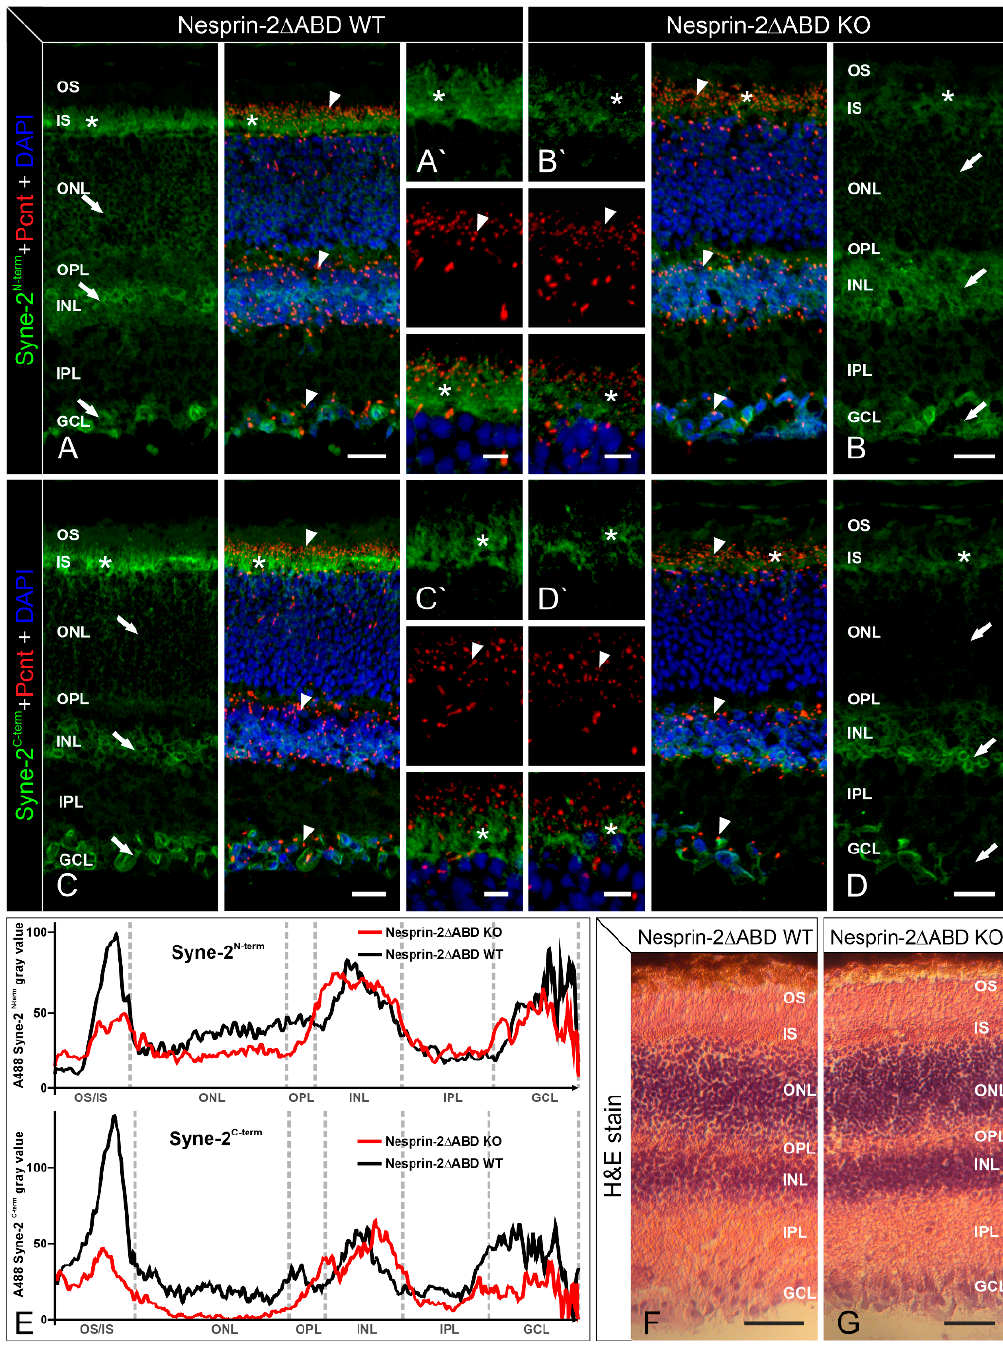
Figure 1. Light microscopic and immunofluorescence analysis of Pcnt and Syne-2 in retinae of Nesprin-2 ∆ ABD mouse strain. Images of vertical sections through adult (age 2–4 month) Nesprin-2 ∆ ABD mouse retinae, stained with antibodies against Syne-2N-term (K56-386, green, A, B) or Syne-2C-term (F-11, green, C, D), Pcnt (MmPeriC1, red), and DAPI (blue). ( A , C ) In Nesprin-2 ∆ ABD wild-type (WT) animals, Syne-2 is localized in the region of the inner segments of photoreceptors (asterisks) and the somata of retinal cells in the ONL, INL, and GCL (arrows). Pcnt is present at the ciliary region of photoreceptors and at the centrosomal region of non-photoreceptors (arrowheads). ( B , D ) In Nesprin-2 ∆ ABD knockout (KO) animals, Syne-2 staining is only faintly visible in the region of the photoreceptor inner segments (asterisk) and the ONL (arrows). There are no obvious differences between Nesprin-2 ∆ ABD WT and KO retinae with respect to the localization of Pcnt (arrowheads). ( A – D ) High-resolution micrographs of the photoreceptor ciliary region. OS: outer segment; IS: inner segment; ONL: outer nuclear layer; OPL: outer plexiform layer; INL: inner nuclear layer; IPL: inner